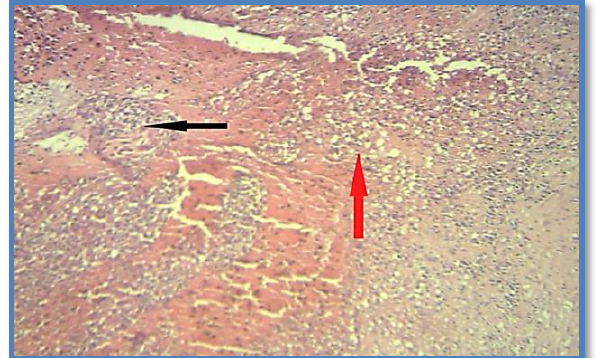
Figure, 11: Micrograph of goat group A congested blood vessels (black arrow), initiated white and red pulp in incision area (red arrow) at 30 th day postoperative (H and E 10 X).